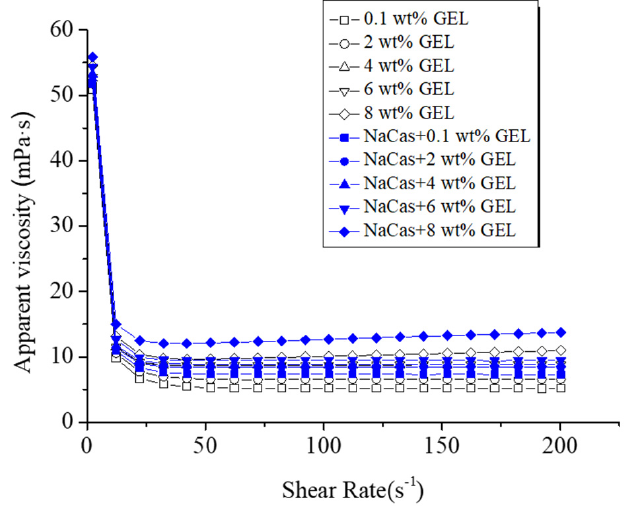
Figure 4. Effect of the different GEL concentrations (0.1, 2, 4, 6, 8 wt%) on the apparent viscosity of CaCO 3 S/O/W emulsions.